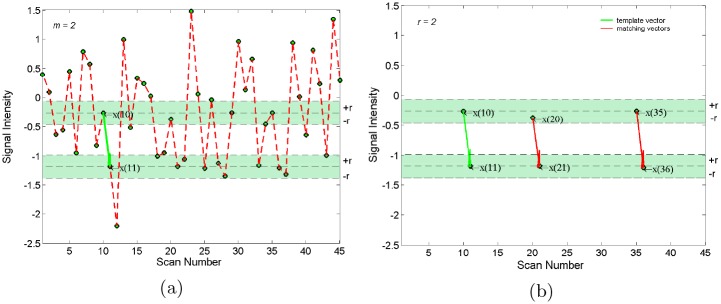
Illustration of SampEn algorithm with the embedding dimension m = 2.The colored bands show the tolerance regions r. (a) Green arrow denotes template vector u(10) = [x(10), x(11)]. (b) Only vectors u(20) = [x(20), x(21)], u(35) = [x(35), x(36)] (red arrow) falling into these bands were counted to match the template vector: u(10) = [x(10), x(11)].